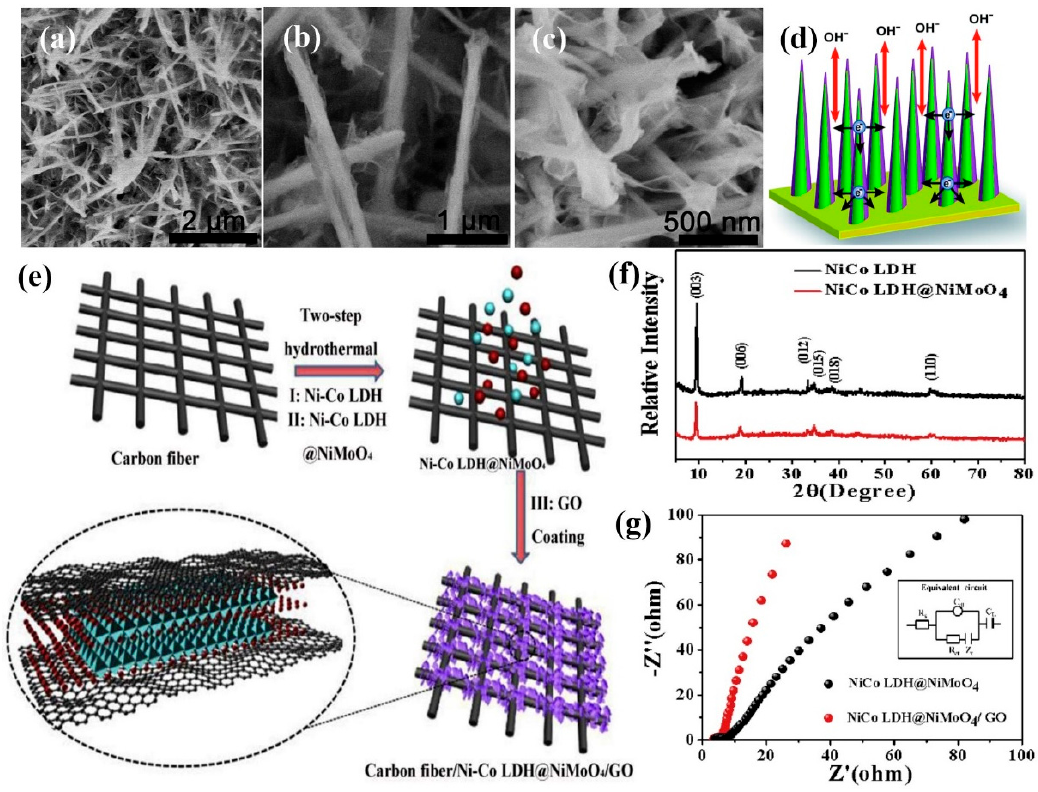
Figure 5. ( a – c ) High magnification SEM images of NiMoO 4 − Co(OH) 2 nanowires on NF, ( d ) Schematic diagram of the high − performance of NiMoO 4 − Co(OH) 2 [114]. Reproduced from Ref. [114] with permission from The Royal Society of Chemistry, 2015. ( e ) The synthesis process of Ni − Co LDH − NiMoO 4 /GO on carbon fiber, ( f ) XRD patterns of Ni − Co LDH and Ni − Co LDH − NiMoO 4 samples, ( g ) EIS of the Ni − Co LDH − NiMoO 4 and Ni − Co LDH − NiMoO 4 /GO electrodes [116]. Reproduced from Ref. [116] with permission from Elsevier, 2019.